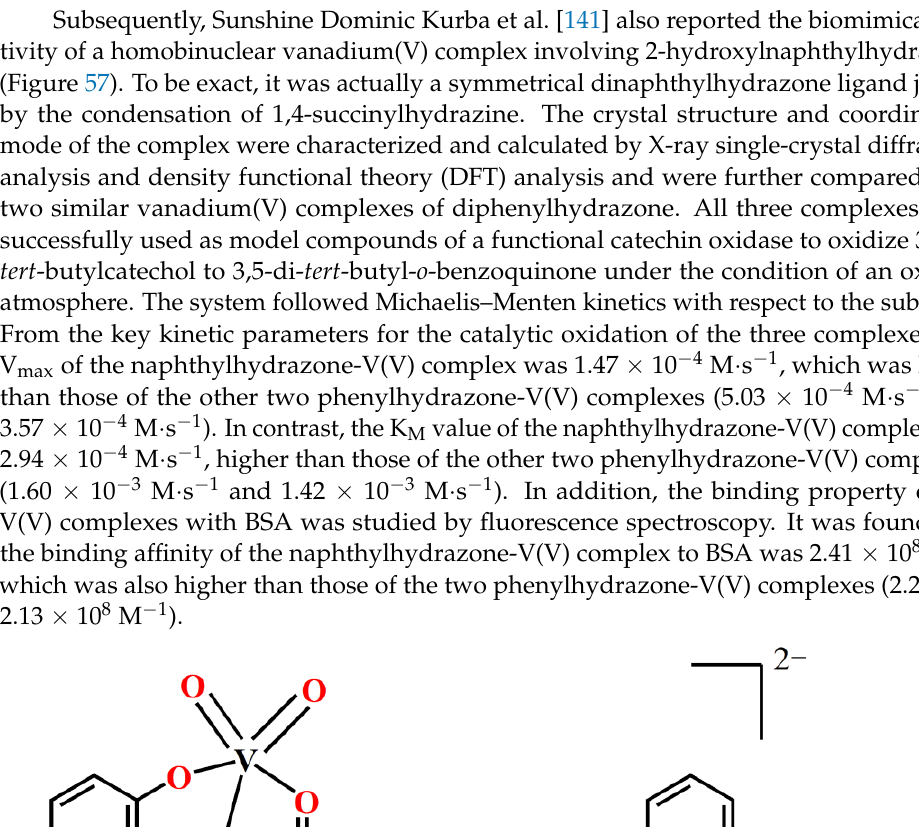
Figure 56. Ni(II)/Co(III) complexes of 9-anthrachydrazone with a benzamide side chain and with bipyridine or o -phenanthroline as a co-ligand.